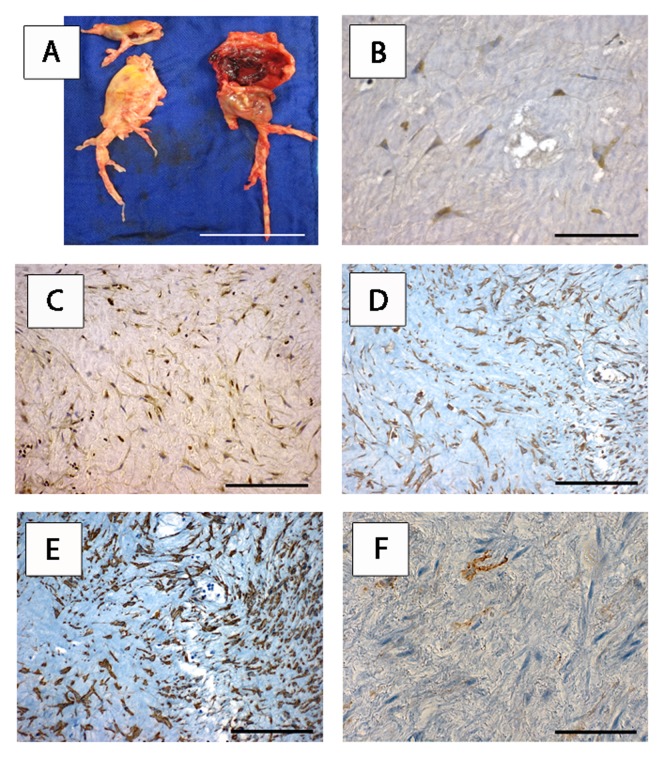
RAGE and HMGB1 are expressed in myofibroblasts of endarterectomised chronic thromboembolic tissues of CTEPH patients.One representative patient is shown (12 out of 15 patients (80%) displayed analogous staining patterns. Photograph showing the macroscopic aspect of a representative PEA specimen (A). Scale bar: 6 cm. Immunohistochemical expression of RAGE (B, scale bar: 20 µm), HMGB1 (C), vimentin (D), alpha-smooth muscle actin (E) and CD34 (F) on adjacent tissue sections of the PEA specimen shown in (A). Scale bar: 40 µm. RAGE receptor for advanced glycation endproducts, HMGB1 high mobility group box 1, CTEPH chronic thromboembolic pulmonary hypertension, PEA pulmonary endarterectomy.